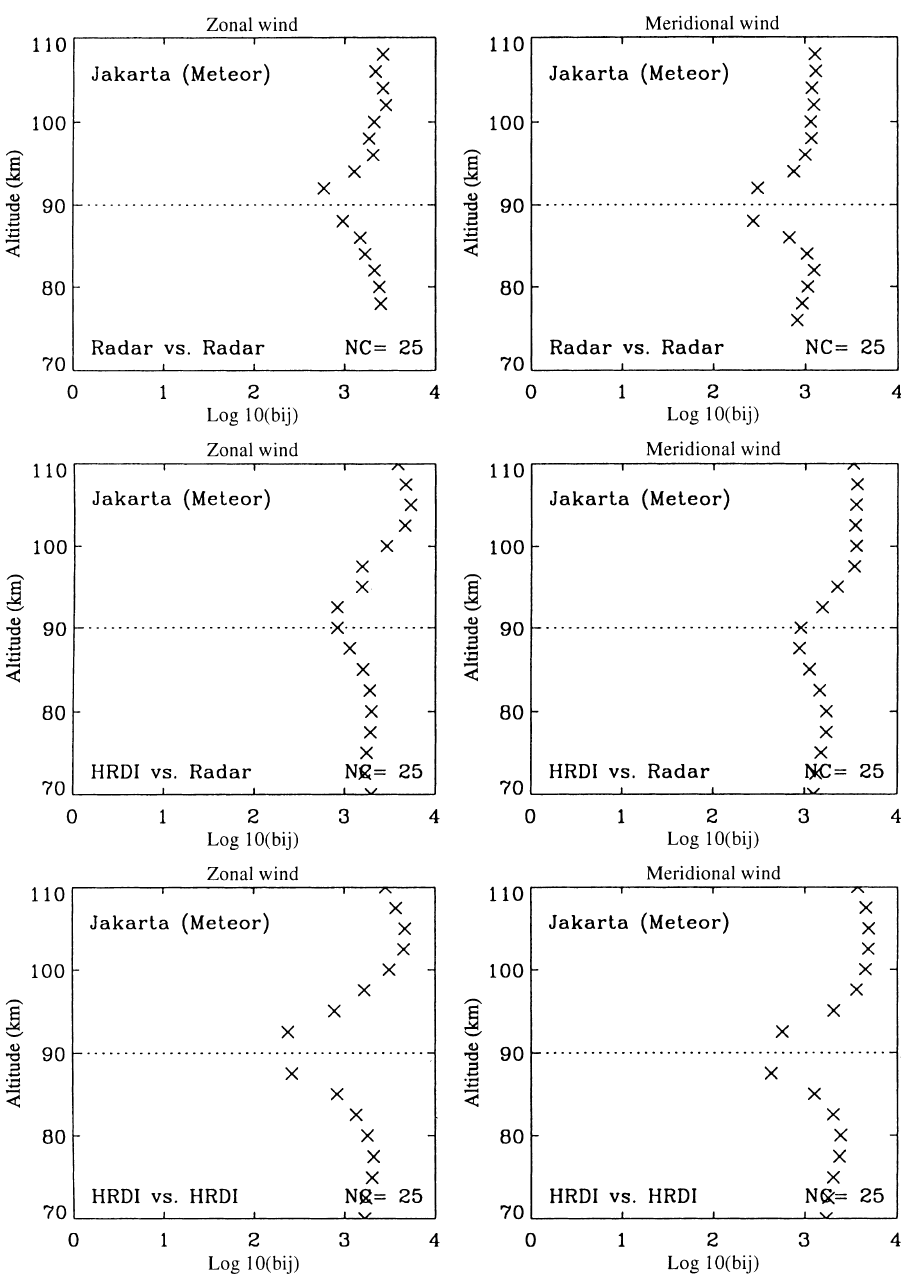
Fig. 9. Examples of the structure functions obtained by the combi- nation of radar vs. radar, HRDI vs. radar, and HRDI vs. HRDI for Shigaraki MU radar (meteor mode) and Jakarta meteor radar both at 90-km